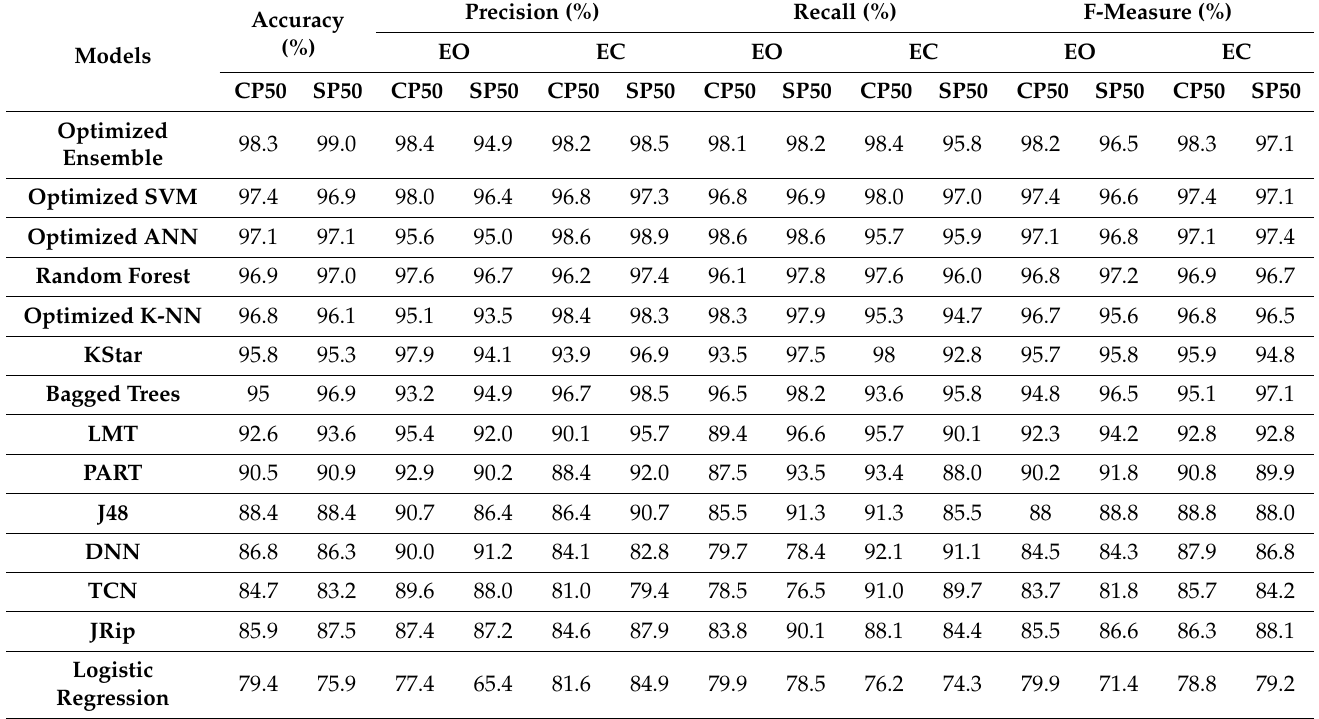
Table 2. The performance of the classifiers on CP50 and SP50